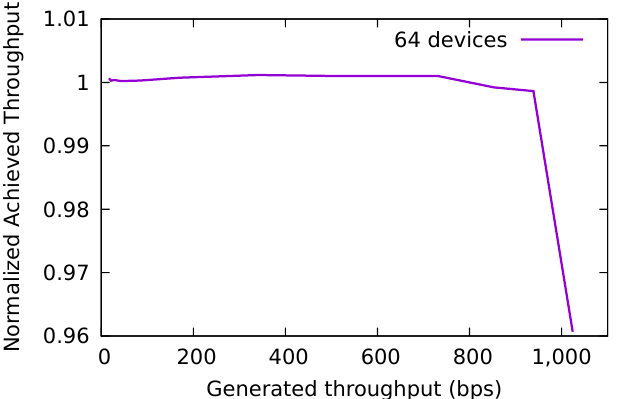
Figure 10. Ratio between the generated and achieved throughput—No Security approach with 64 devices.